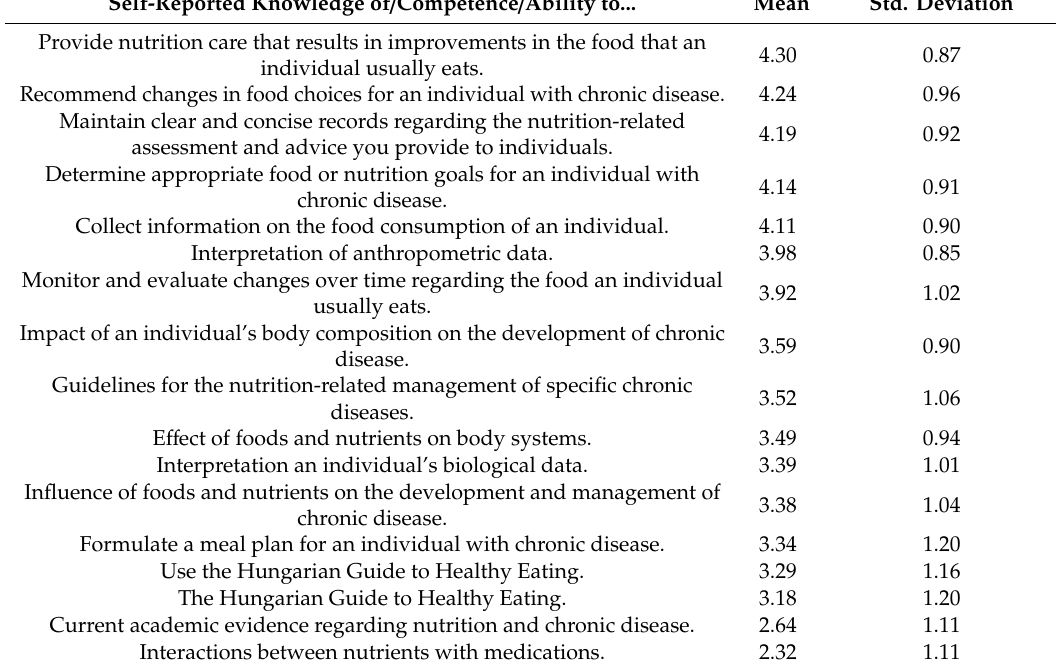
Table 3. Results of descriptive statistics on nutrition-related knowledge and skills, measured on a 1–5 Likert scale (1—absolutely not agree and 5—totally agree) in descending ordering, according